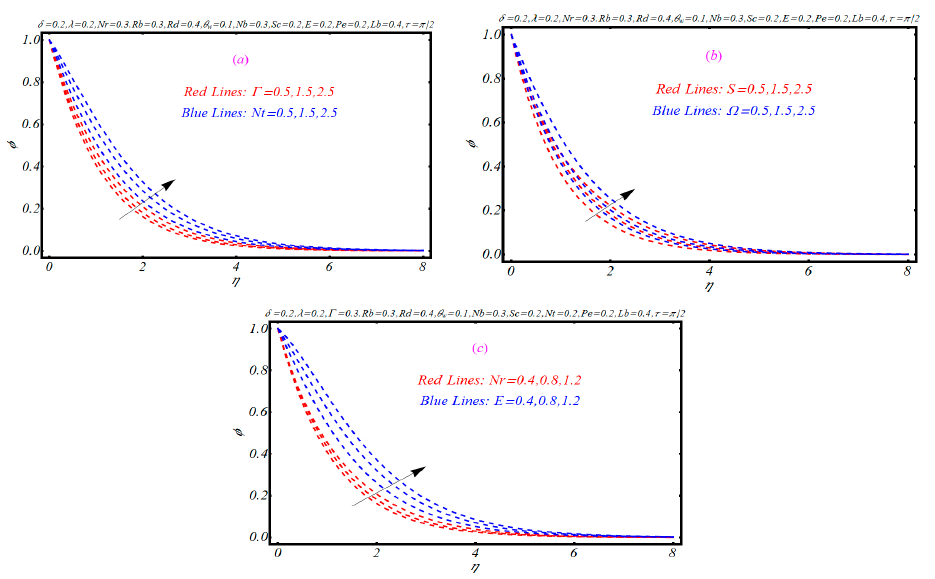
Figure 4. Variation in φ for ( a ) Nt and Γ , ( b ) S and Ω , ( c ) Nr and E .